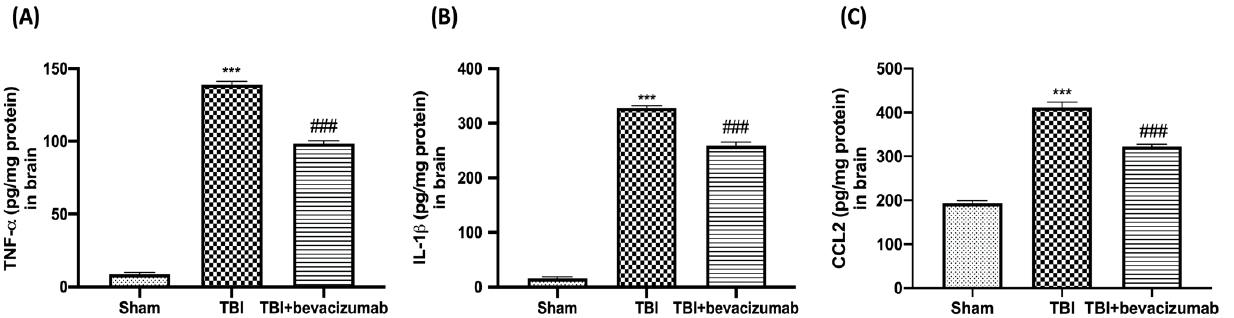
Figure 5 . Effects of bevacizumab on TNF-α, IL-1β and CCL2 in the brain after TBI. TNF-a, IL-1b and CCL2 levels were quantified by ELISA in the brain tissue lysate 24 h after TBI. Results show significantly increased levels of TNF-a ( A ), IL-1b ( B ) and CCL2 ( C ) in the brains of TBI mice compared with Sham mice. Bevacizumab treatment significantly restored the levels of these pro-inflammatory cytokines and chemokines. Data are expressed as mean ± SD from n = 5 mice/group. *** p < 0.001 vs. Sham; ### p < 0.001 vs. TBI. Astrocytes and microglia activation are key components of the progression of TBI.